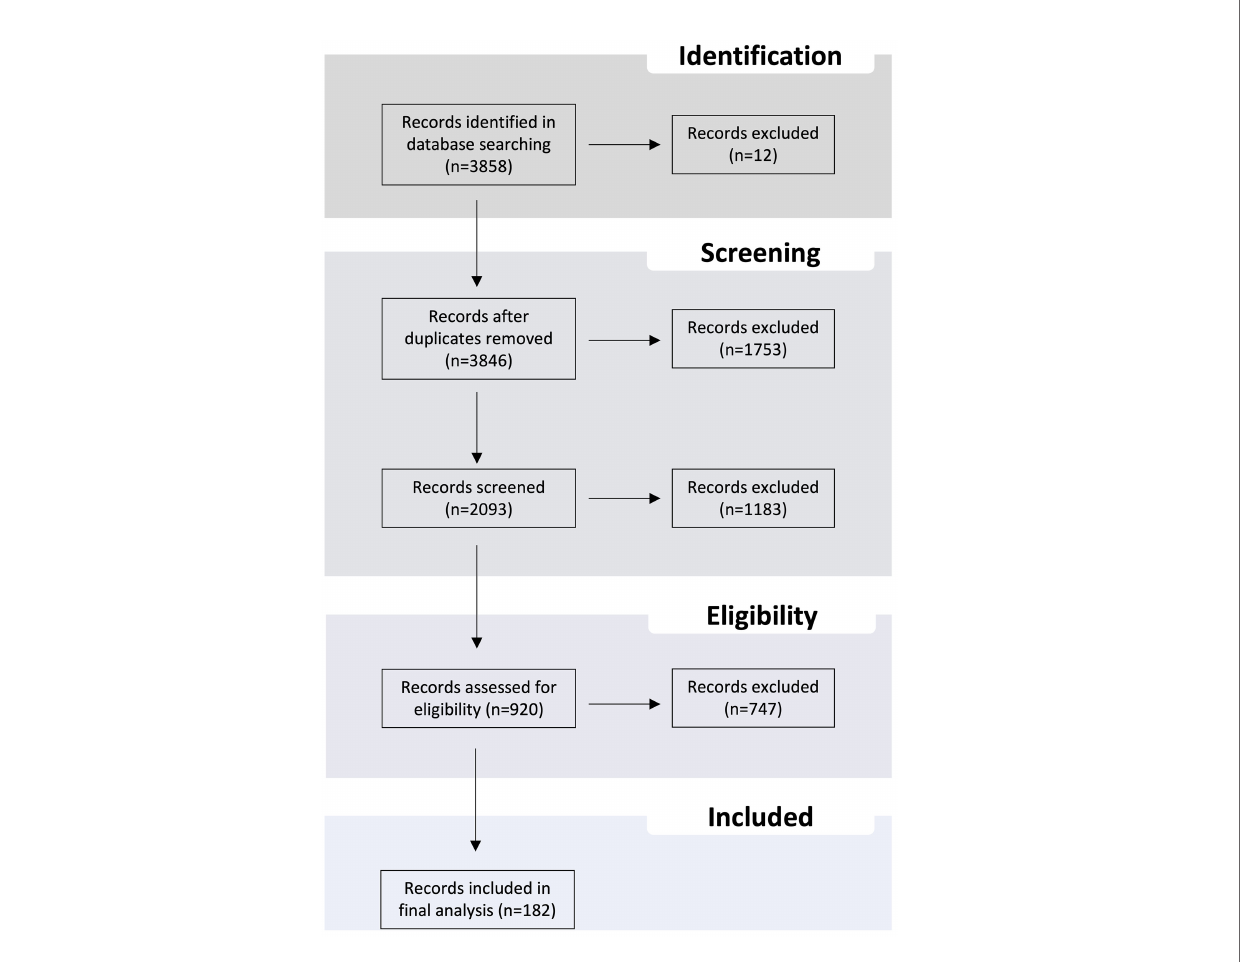
FIGURE 3 | Flux gram presenting the summary of the methodology used in this